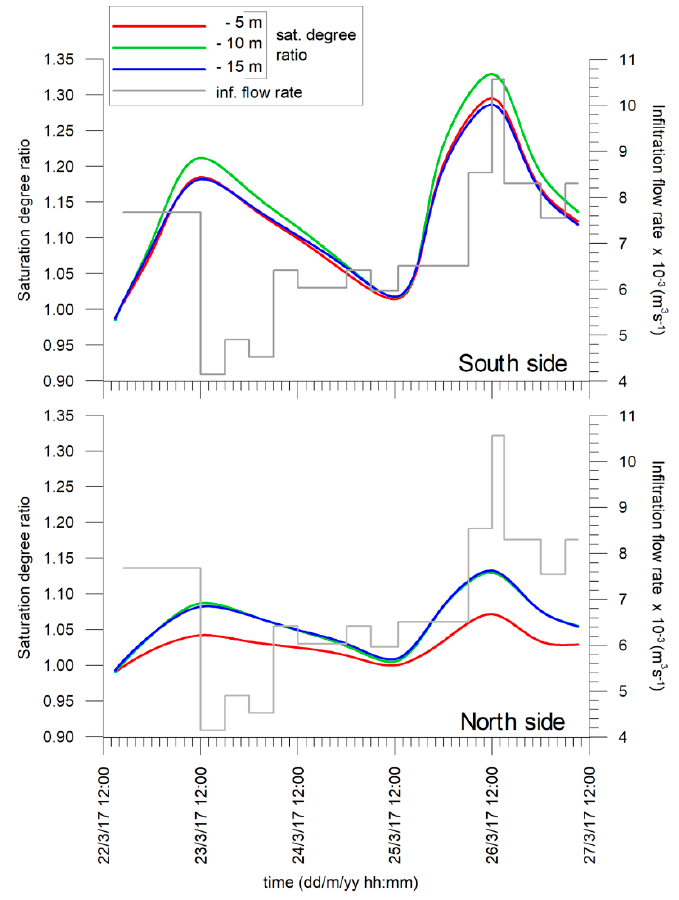
Figure 10. Average saturation degree changes vs. infiltration flow rate recorded at three depths during the monitoring in March. the monitoring in